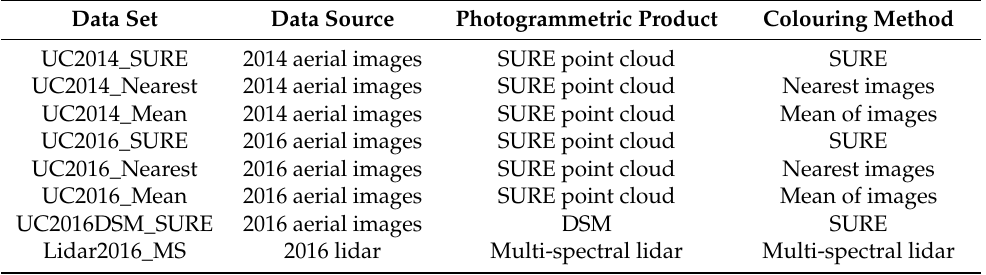
Table 1. Data sets and different colouring